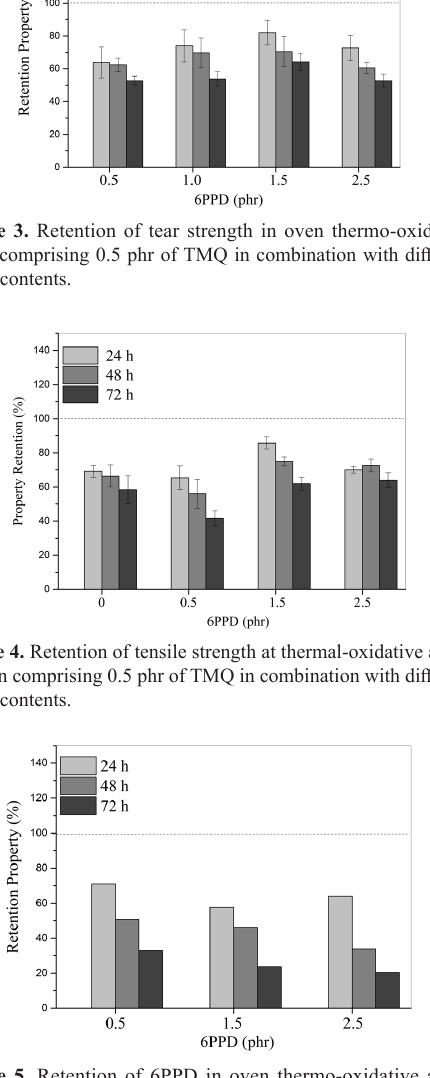
Figure 5. Retention of 6PPD in oven thermo-oxidative aging comprising 0.5 phr of TMQ in combination with different 6PPD contents.